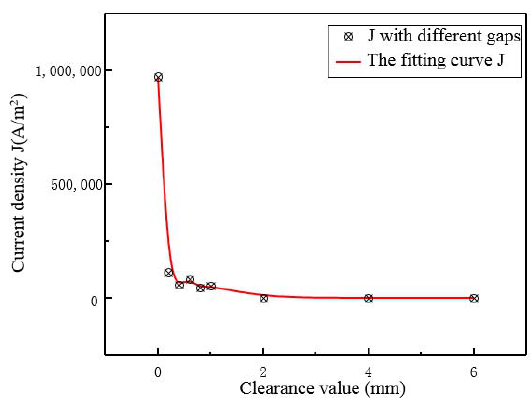
Figure 10. Maxwell current density simulation results with different spacing.